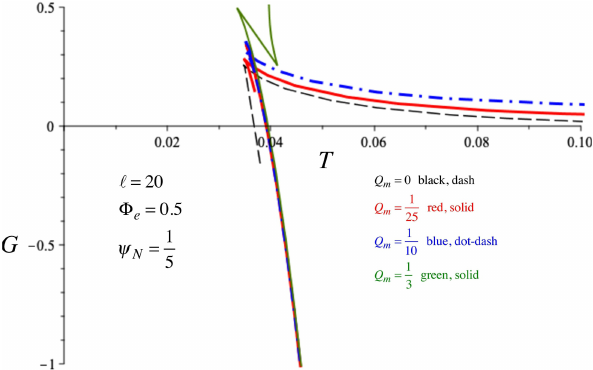
Figure 23 . Snapping Fractured Cusp. This structure develops for vanishing ψ ( I ) The discontinuity in the fractured cusp widens as Q m increases, with the right-hand branch van- ishing (snapping away), leaving a single curve that is very steep for small T .